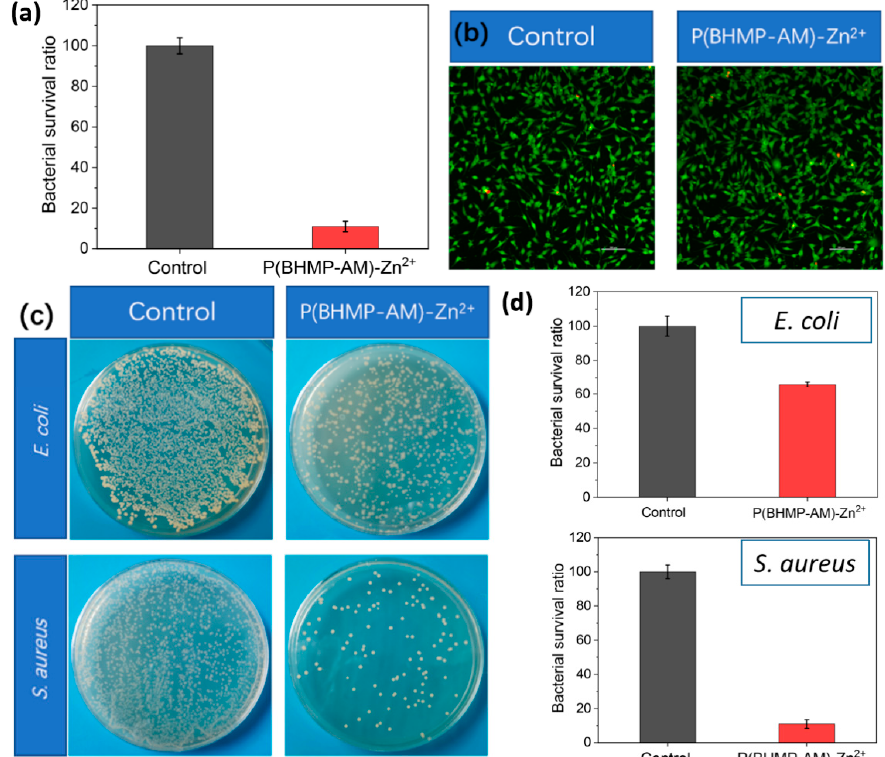
Figure 7. ( a ) Live/dead staining of L929 cells in contact with the P(BHMP-AM)-Zn 2+ hydrogel after 1 d. ( b ) Cell viability after 1 d in contact with the P(BHMP-AM)-Zn 2+ hydrogel. The error bars represent the standard deviation ( n = 3). ( c ) Images of the E. coli and S. aureus colonies displayed on an agar plate after contact with the hydrogel. ( d ) Surface antibacterial activities of E. coli and S. aureus after hydrogel treatment. The data are expressed as the mean values obtained from three measurements ( n = 3).